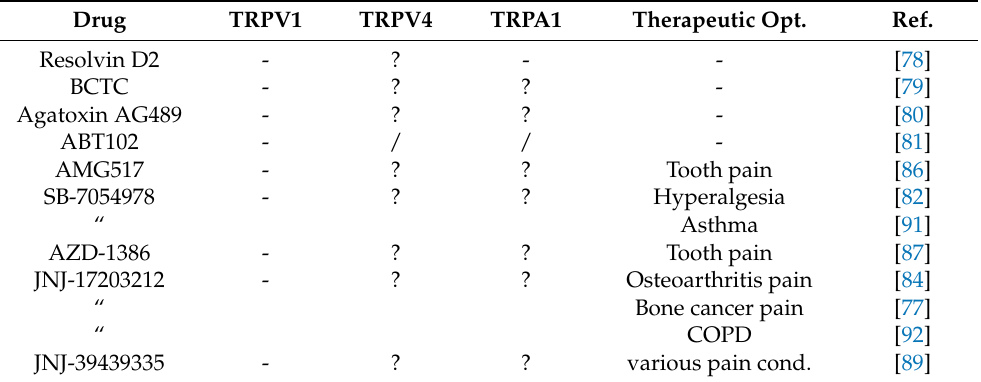
Table 3. Selected compounds inhibiting TRPV1 activity and prospective therapeutic options. Drug TRPV1 TRPV4 TRPA1 Therapeutic Opt. Ref. Resolvin